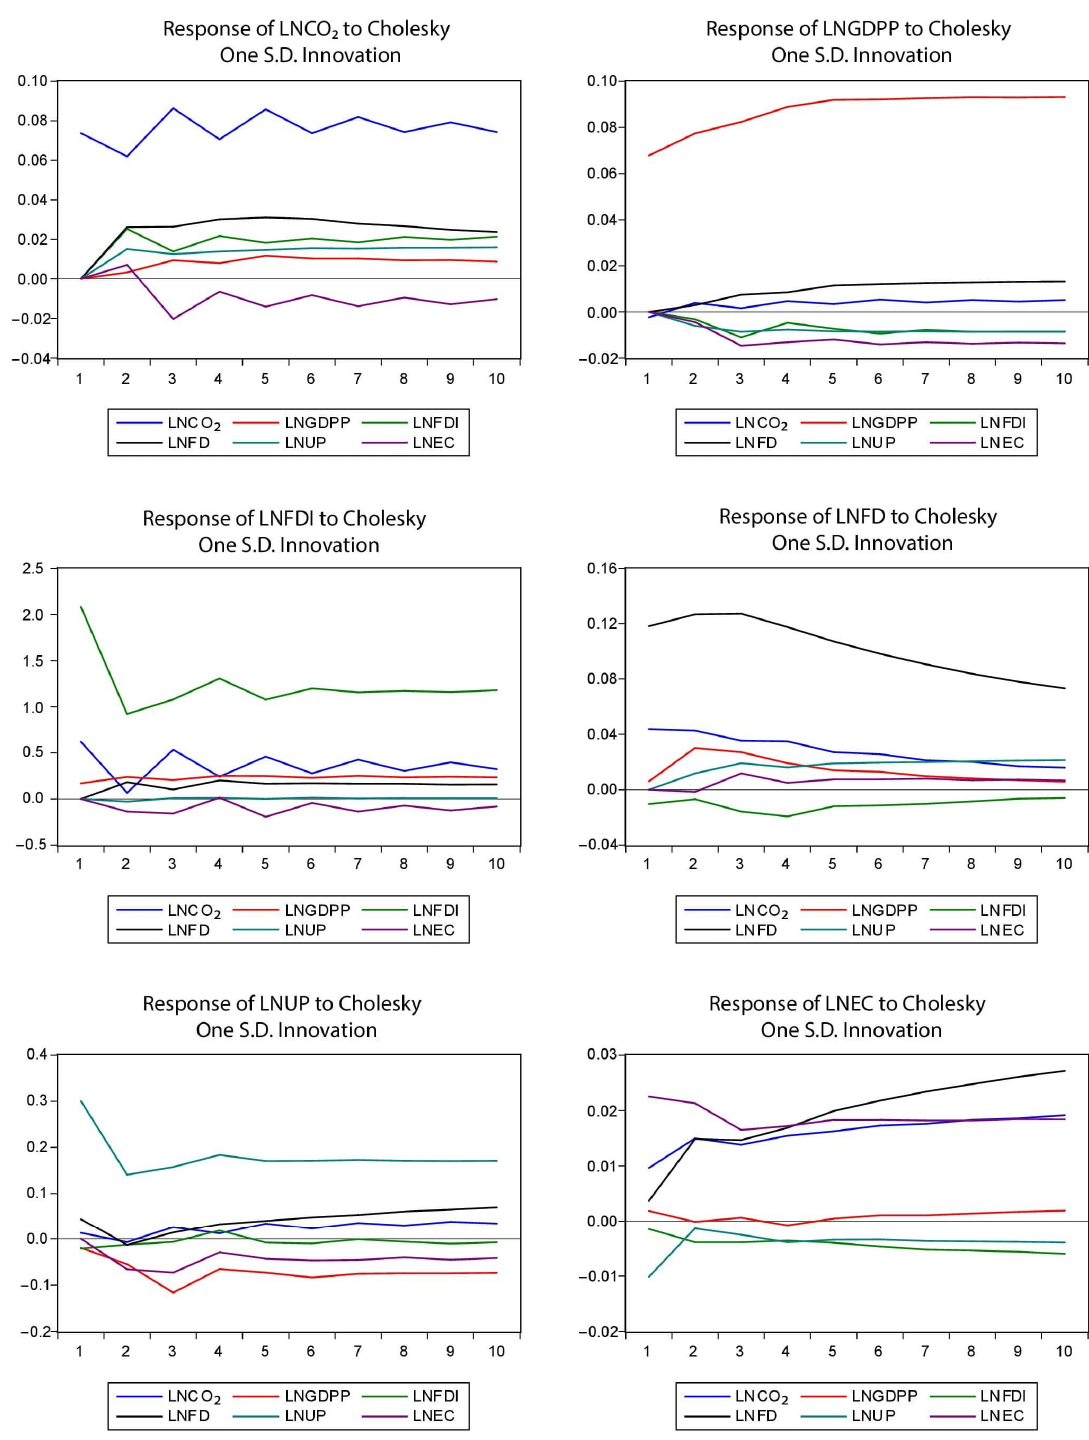
Figure 1. Impulse response analysis .